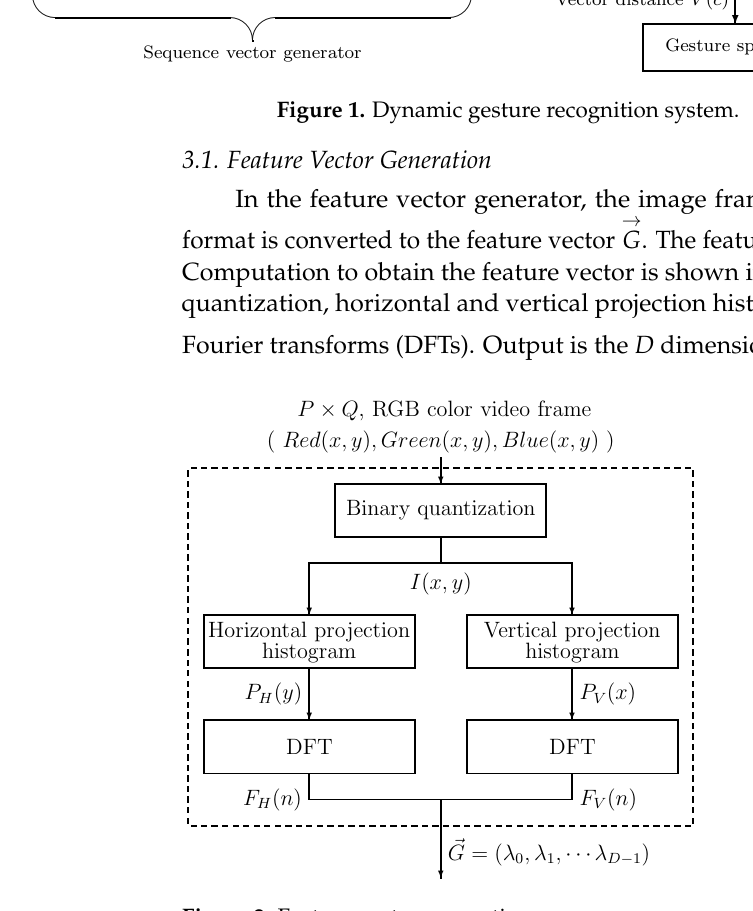
Figure 2. Feature vector generation.